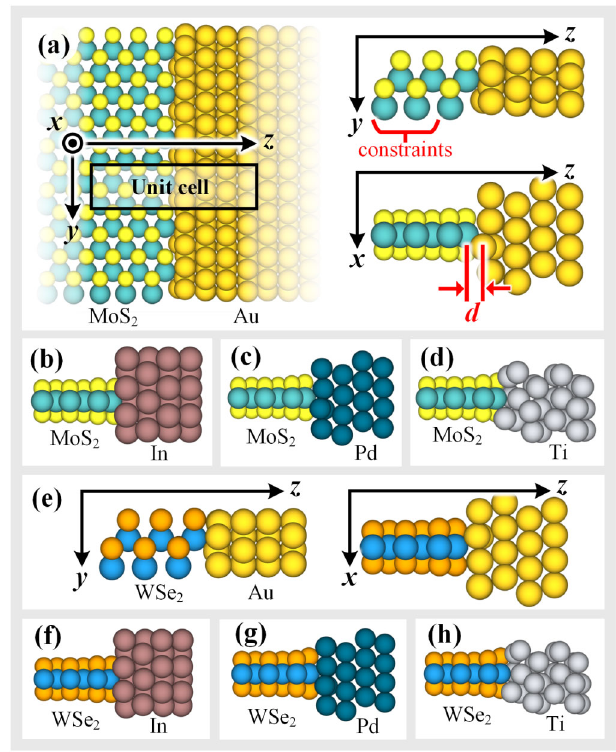
FIG. 18. Optimized geometries of edge contacts: (a) Au-MoS 2 (in different views), (b) In-MoS 2 , (c) Pd-MoS 2 , (d) Ti-MoS 2 , (e) Au-WSe 2 (in different views), (f) In-WSe 2 , (g) Pd-WSe 2 , and (h) Ti-WSe 2 . The large-volume overlaps of metal and chalco- genide atomic spheres exist in every edge contact [in (a) – (h)], indicating the formation of strong covalent bonds. Hence, physical separations in edge contacts (Table I) are much smaller than that of top contacts in Figs. 8 and 9 due to the covalent bonds formed between mTMD and